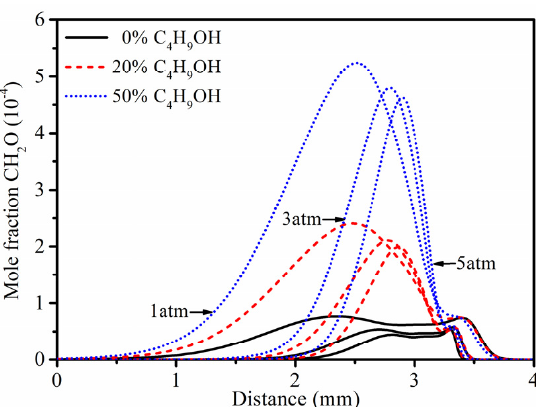
Figure 12. Mole fractions of CH 2 O, with different levels of n -butanol at different pressures.